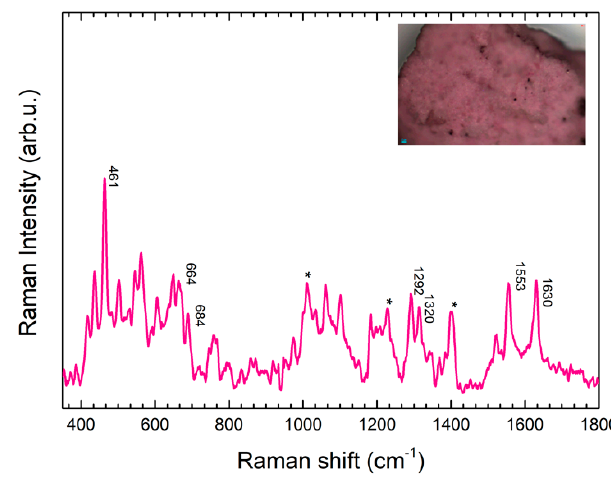
Figure 10. SERS spectrum of a pink pigment sample, collected from area 5 by GT-SERS, showing characteristic peaks of madder lake. Asterisks are indicative of gel substrate peaks.